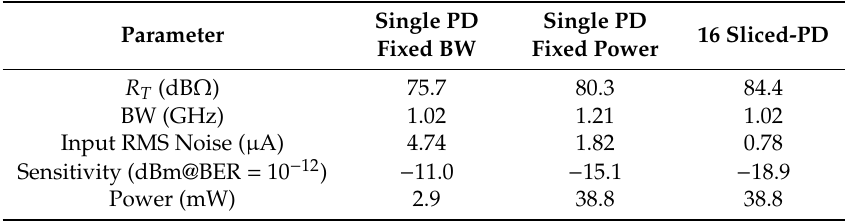
Table 2. Comparison of the simulation results with optimized parameters for both approaches, the traditional approach, and applying the sliced-PD,